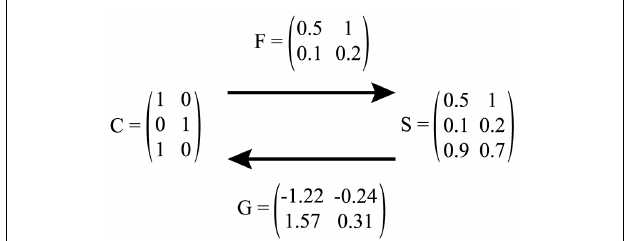
FIGURE 2 | Illustration of mapping between C and S matrix via F (i.e., comprehension), and S and C matrix via G (i.e., production). In production, C is referred to as T